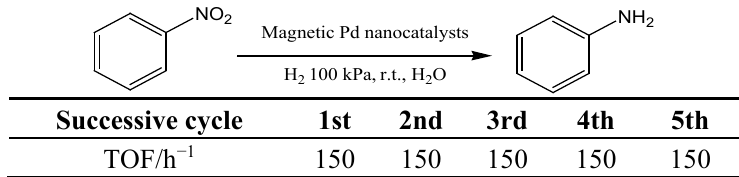
Table 1. Magnetic recovery and recycling of the Pd@γ -Fe 2 O 3 nanocatalysts in the hydrogenation of